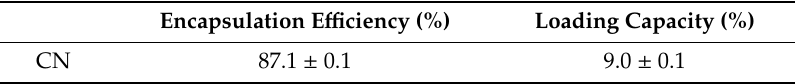
Table 2. Properties of nanospheres loaded with